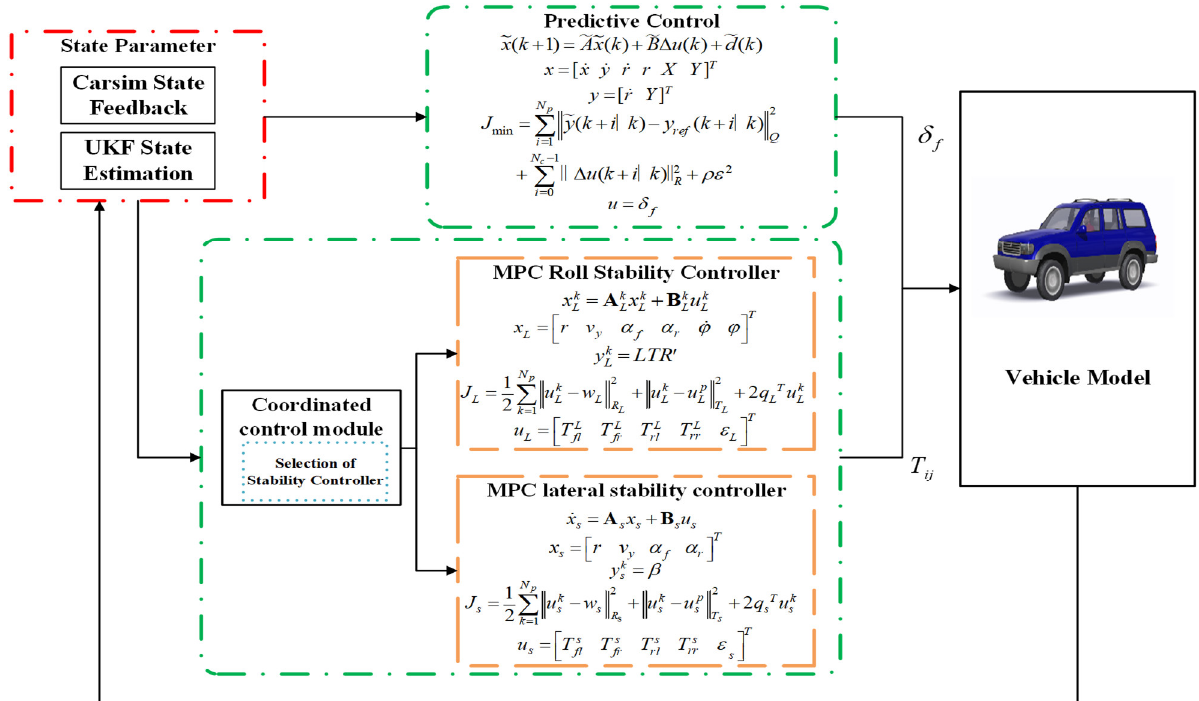
Figure 4. Path tracking stability control logic diagram.